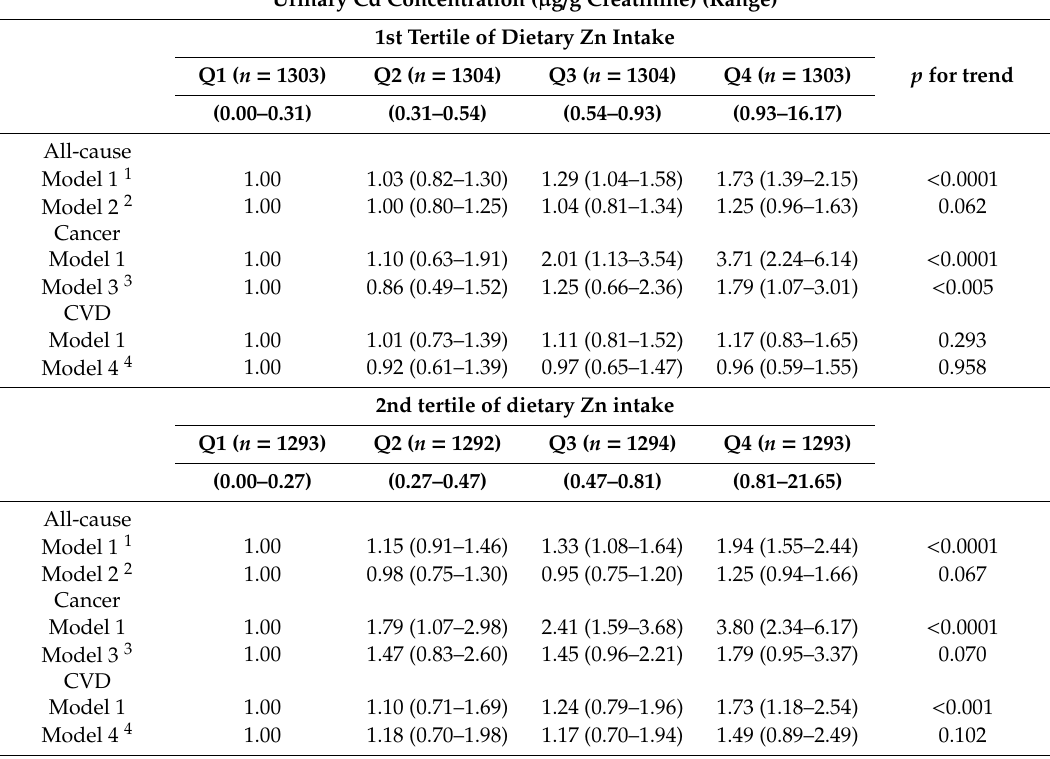
Table 4. Multivariable adjusted HR (95% CI) of all-cause, cancer and CVD mortality using Cox proportional hazards models among US adults ≥ 30 years old in NHANES 1988–2004 by quartile of urinary Cd concentration by tertile of Zn intake ( n =